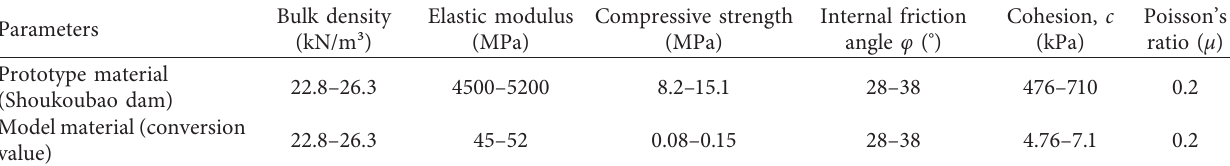
Table 1: Physicomechanical target parameters of the